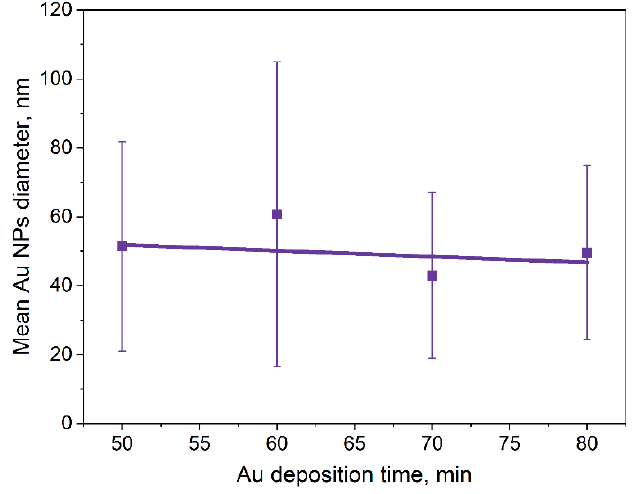
Figure 7. Mean Au NP diameter as a function of the gold deposition time on the macro-PS.